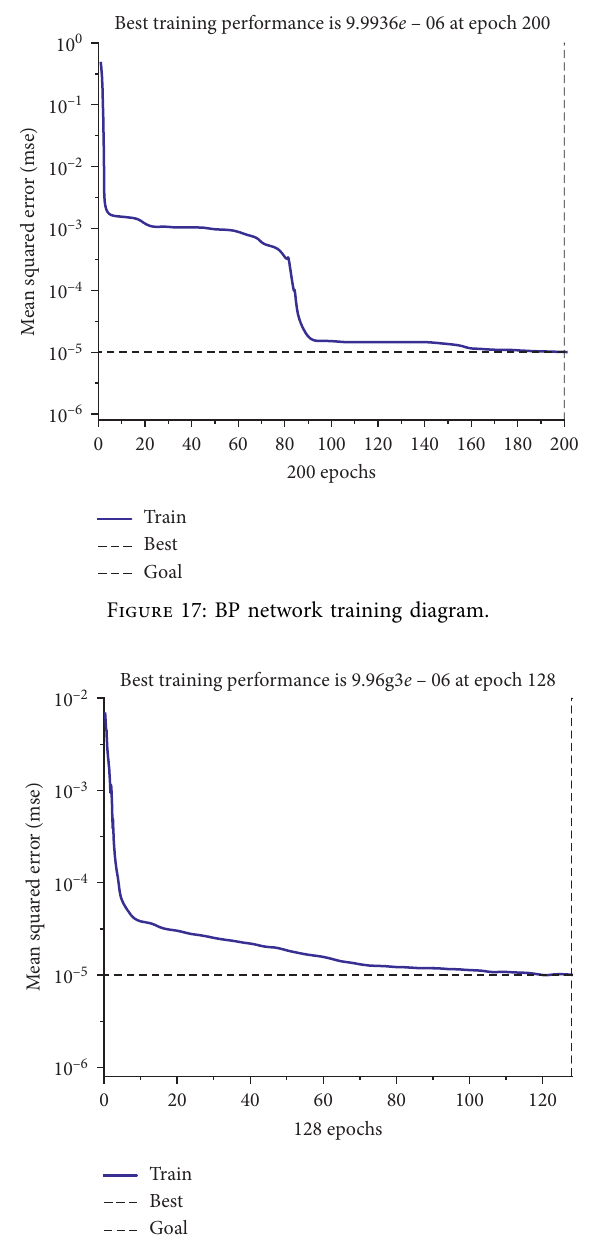
Figure 18: PSO-BP network training